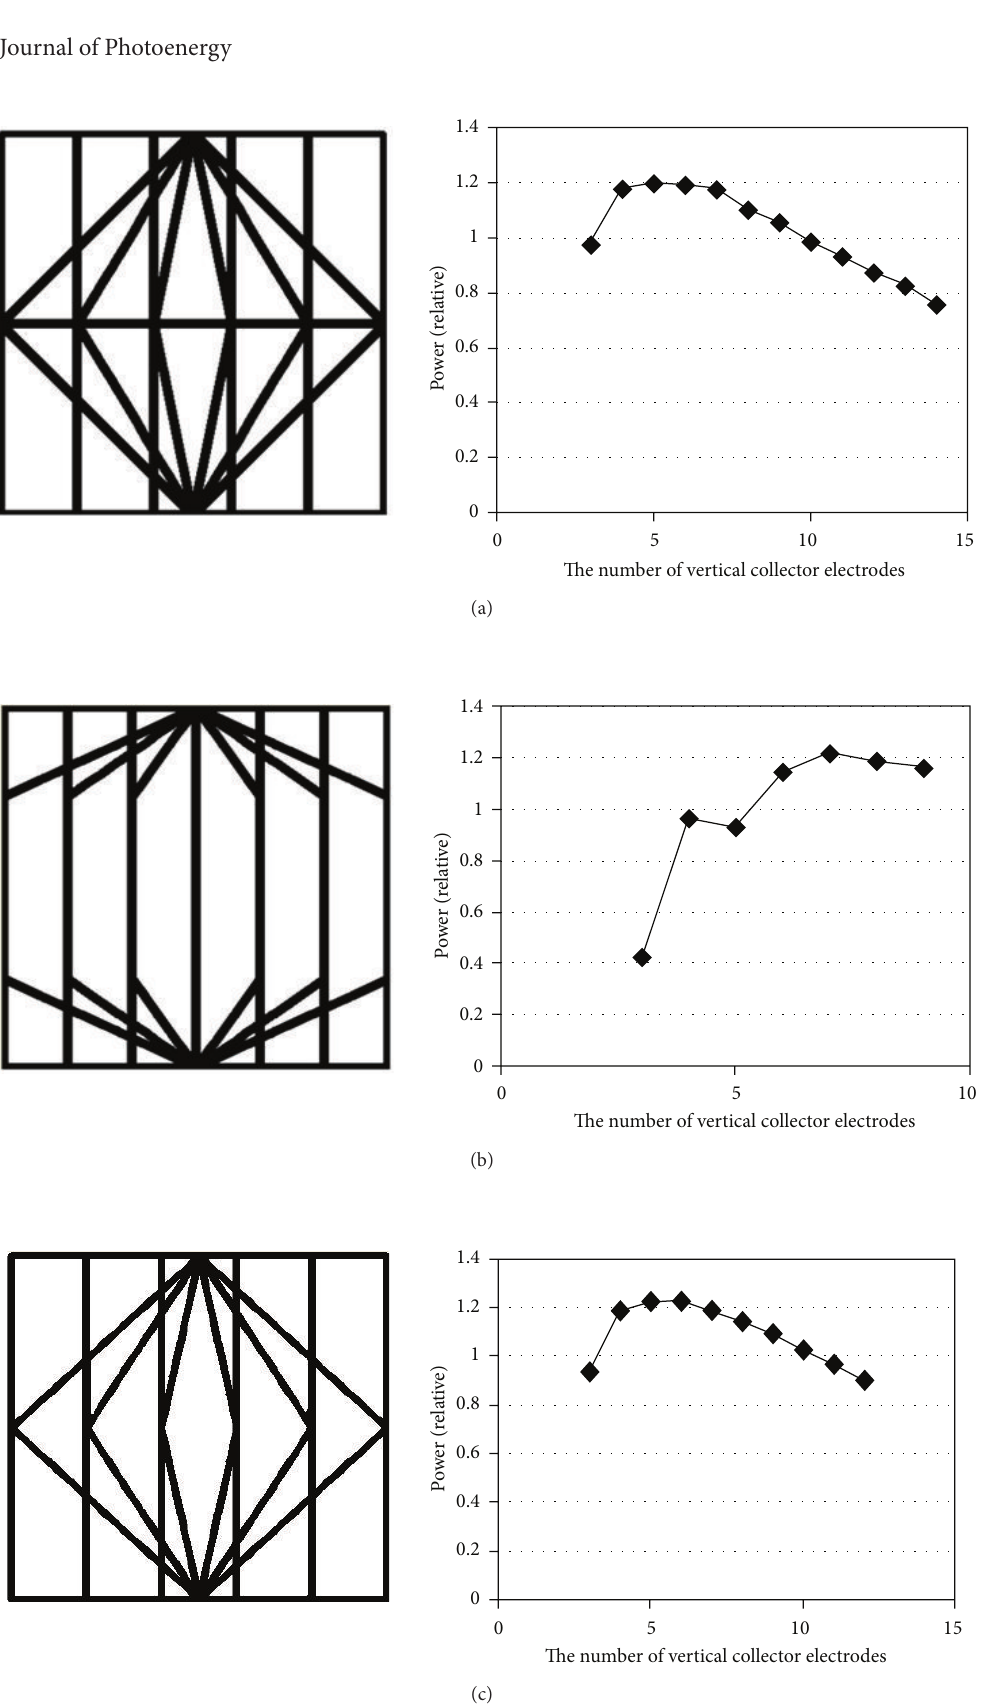
Figure 9: The optimized geometries and the dependence of the output power on the number of the vertical electrode for (a) Geometry 2, (b) Geometry 3, and (c) Geometry